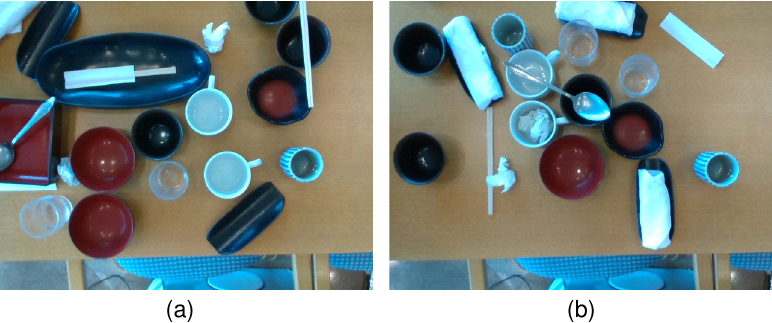
Figure 1. Examples of dish photos waiting to be detected. ( a ) first example, ( b ) second